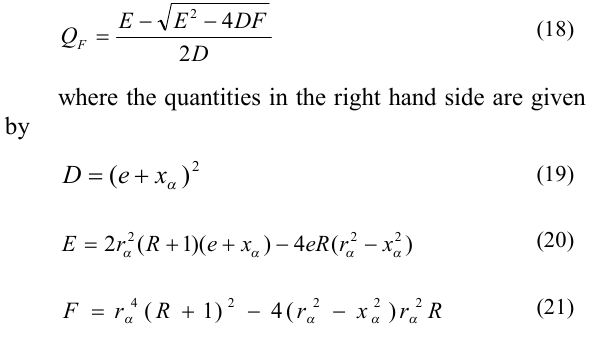
Using the equations (22) and (23), we can see the relationship between the empirical formula (5) and Equation (24). The comparison leads to a conclusion that the empirical formula corresponds to Equation (5) if the following relationship holds.